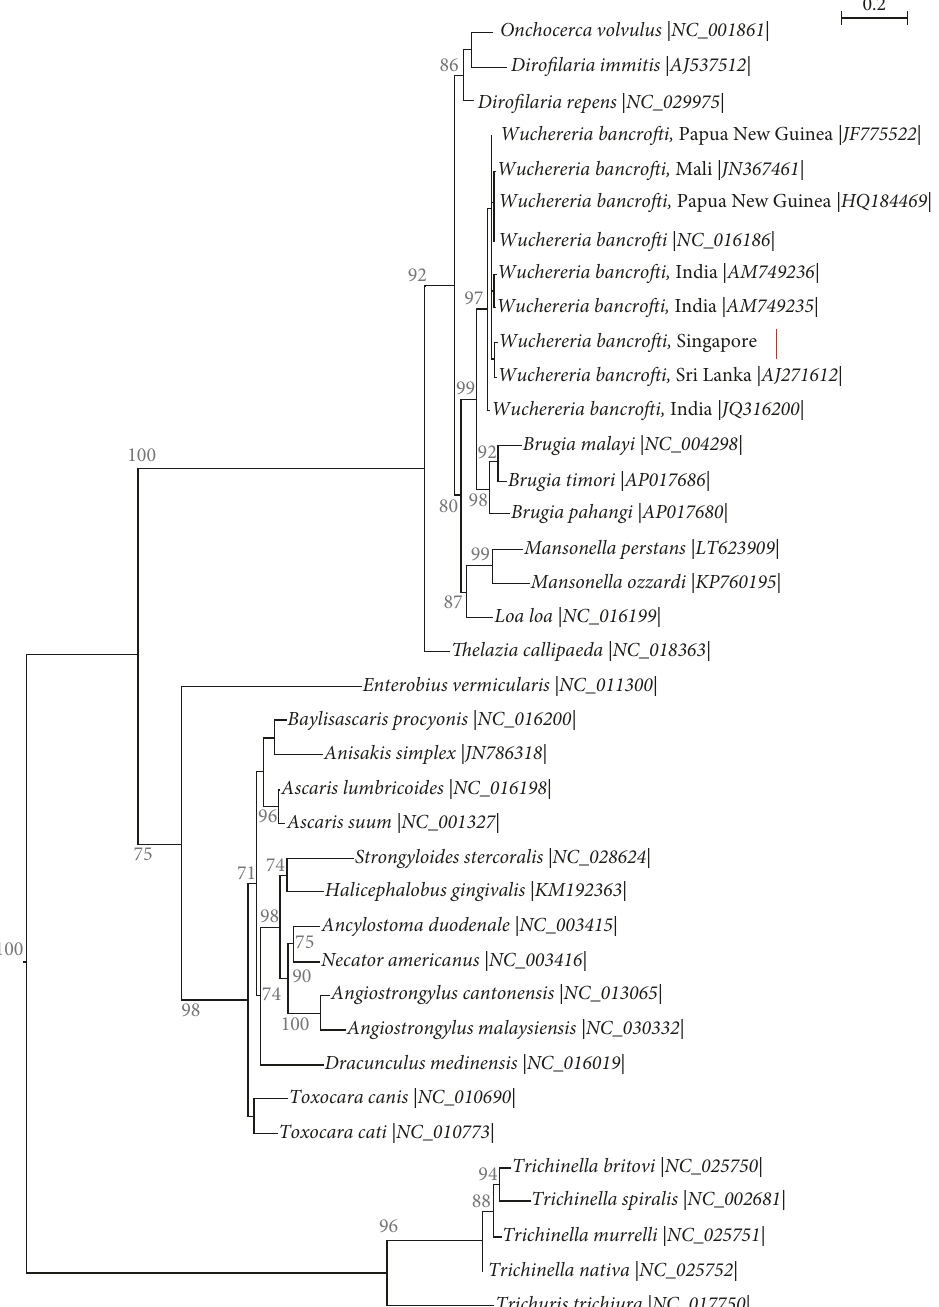
Figure 2: Molecular phylogeny of common parasitic human roundworms based on the cox1 gene. The analysis is inferred by ML method with GTR+ Γ model of evolution. It included 37 DNA sequences downloaded from GenBank (accession number provided between vertical bars) and the sequence obtained from the present case. The parasites of the order Trichocephalida serve as outgroup to root the tree. The tree with the highest log likelihood ( − 5385.0252) is displayed. One thousand nonparametric bootstrap analyses were used to assess nodal robustness and tree topology reliability, branch support > 70% only shown. Lines highlight lymphatic filaria (blue); among them are the Wuchereria parasites (green) and within this genus the sequence obtained from the present case (red),